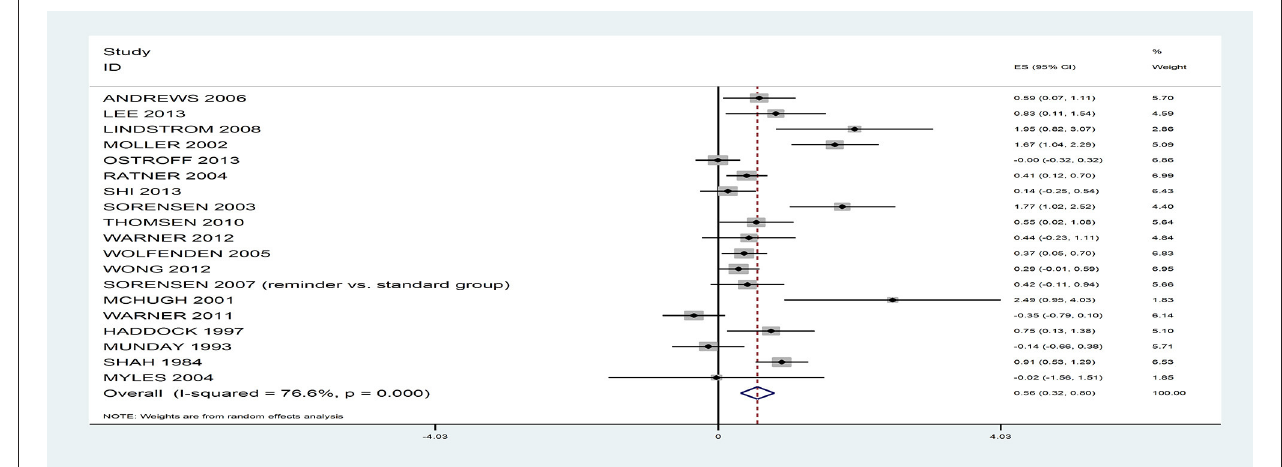
FIGURE 2 | Forest